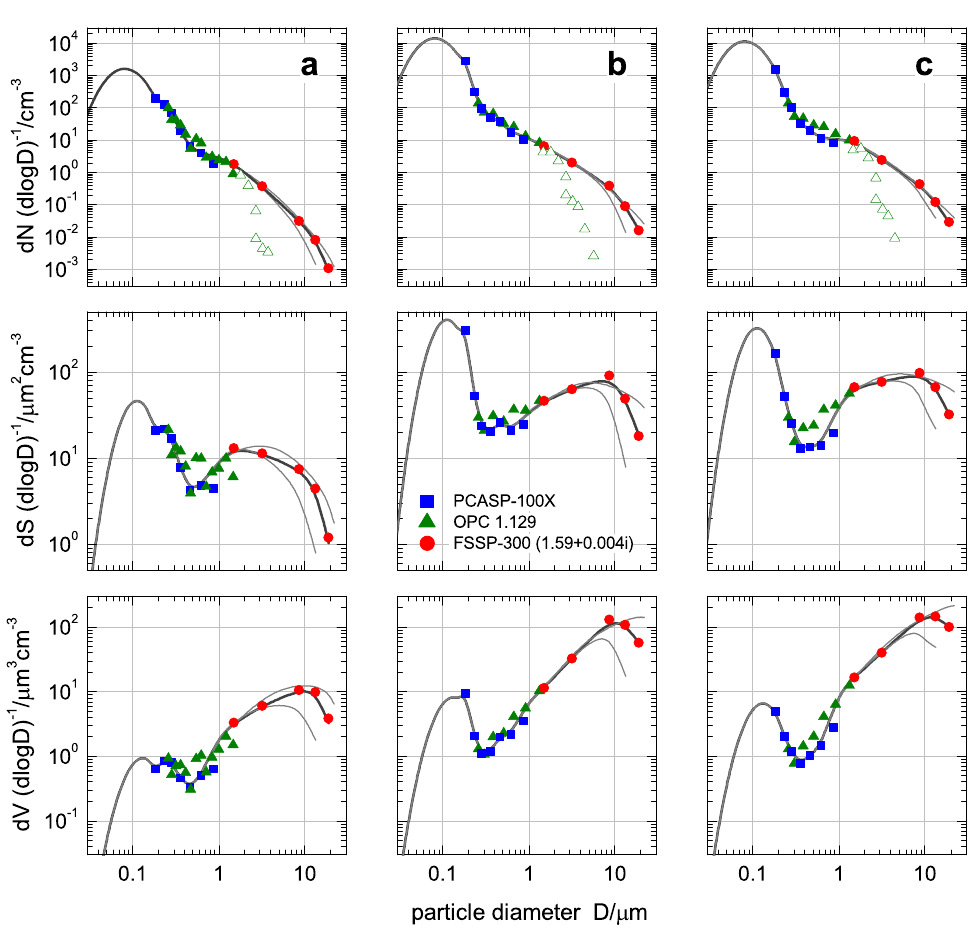
Fig. 7. Particle number N , surface S , and volume V per unit size interval and unit ambient volume versus particle diameter D averaged over the flight legs 1, 6, and 10 (16:11:45–16:19:55UTC) of Table 3, i.e. (a) Leipzig, 19 April, (b) North Atlantic, 2 May, and (c) North Sea, 17 May 2010. PCASP data points are given as blue square symbols, OPC data as green triangles (open symbols represent particle sizes affected by low penetration efficiency of the inlet). Red circles represent FSSP data for case M (see Table 5). The analyzed spectra are plotted as grey curves for cases M (thick), L (thin lower), and H (thin upper